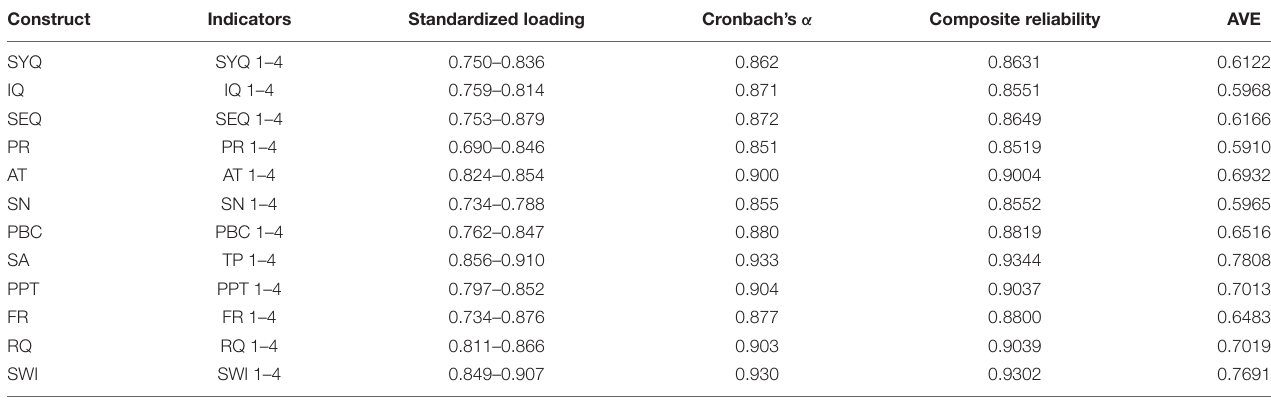
TABLE 2 | Convergent validity and reliability (entire samples).